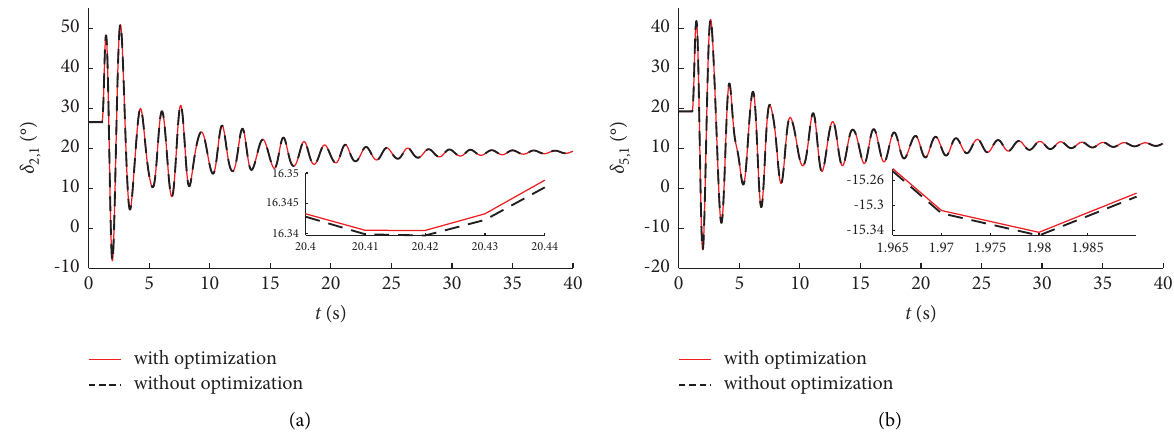
pr and K ir of the CCC. (a) Power-angle diference pr and K ir